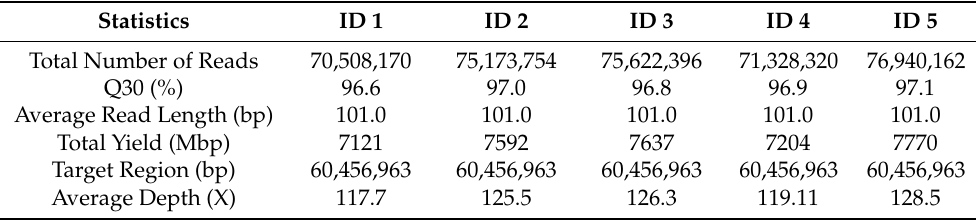
Table 1. Statistics obtained before alignment of reads with the reference genome.